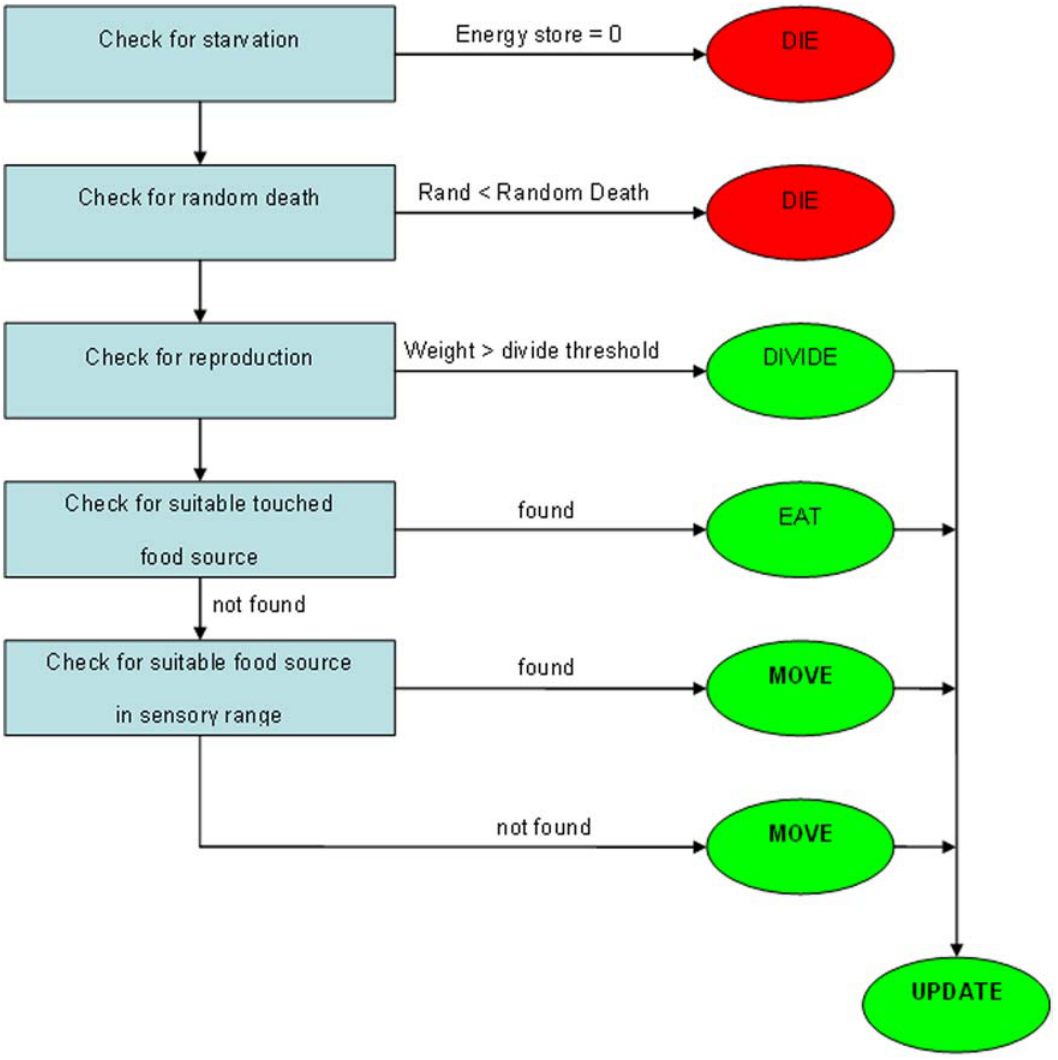
Figure 3. In each turn of the simulation all unicells are treated in a fixed order. If the unicell starves or dies due to the chance of random death it is removed from the simulation (though this could be modeled by saprophytes). If its energy store is sufficient then the unicell divides, creating two new unicells. These child unicells are usually half the size of their parent but there is a small chance of uneven division. New unicells cannot take any action in the first turn they are created and a unicell that divides can take no further action that turn. If a unicell doesn’t have sufficient energy to divide it looks for food. First it considers what the best source of food is within its physical radius, if there is no suitable source then it will move towards the best source in its sensory